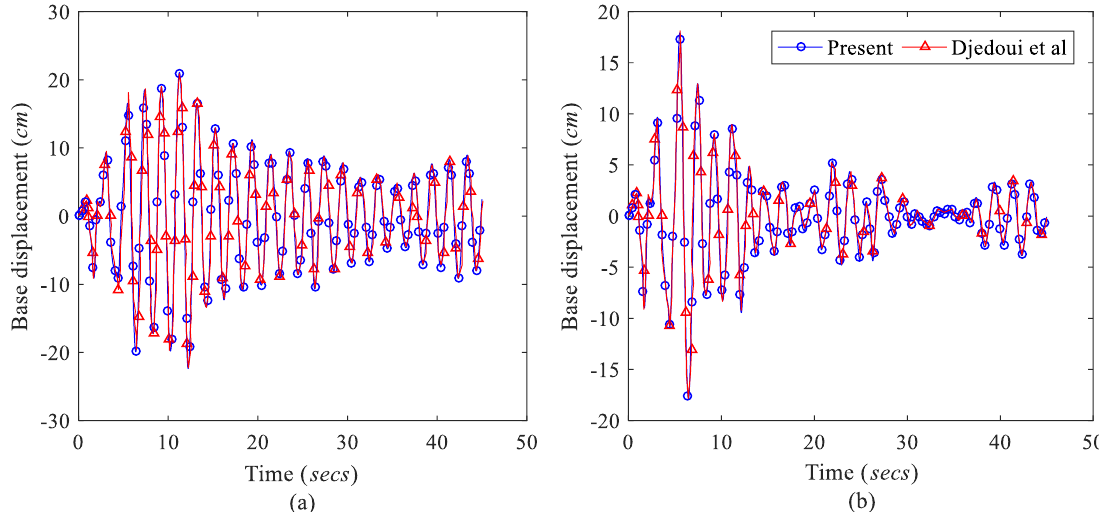
Fig. 5. (a) Base displacement of 5 storey with isolator (b) Base displacement of 5 storey with isolator and TMD under EI Centro